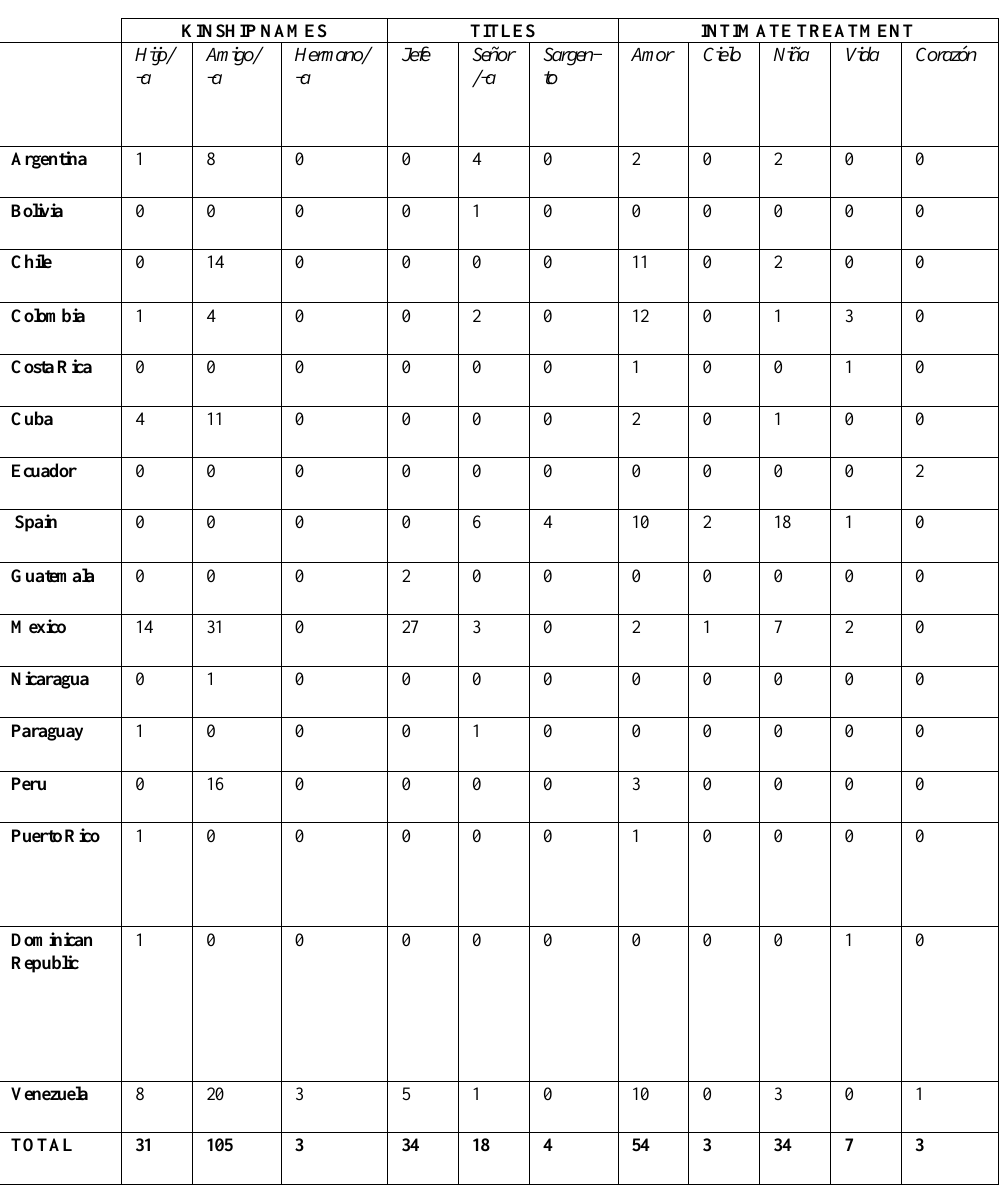
Table 1: Samples of the use of possessives + nouns as